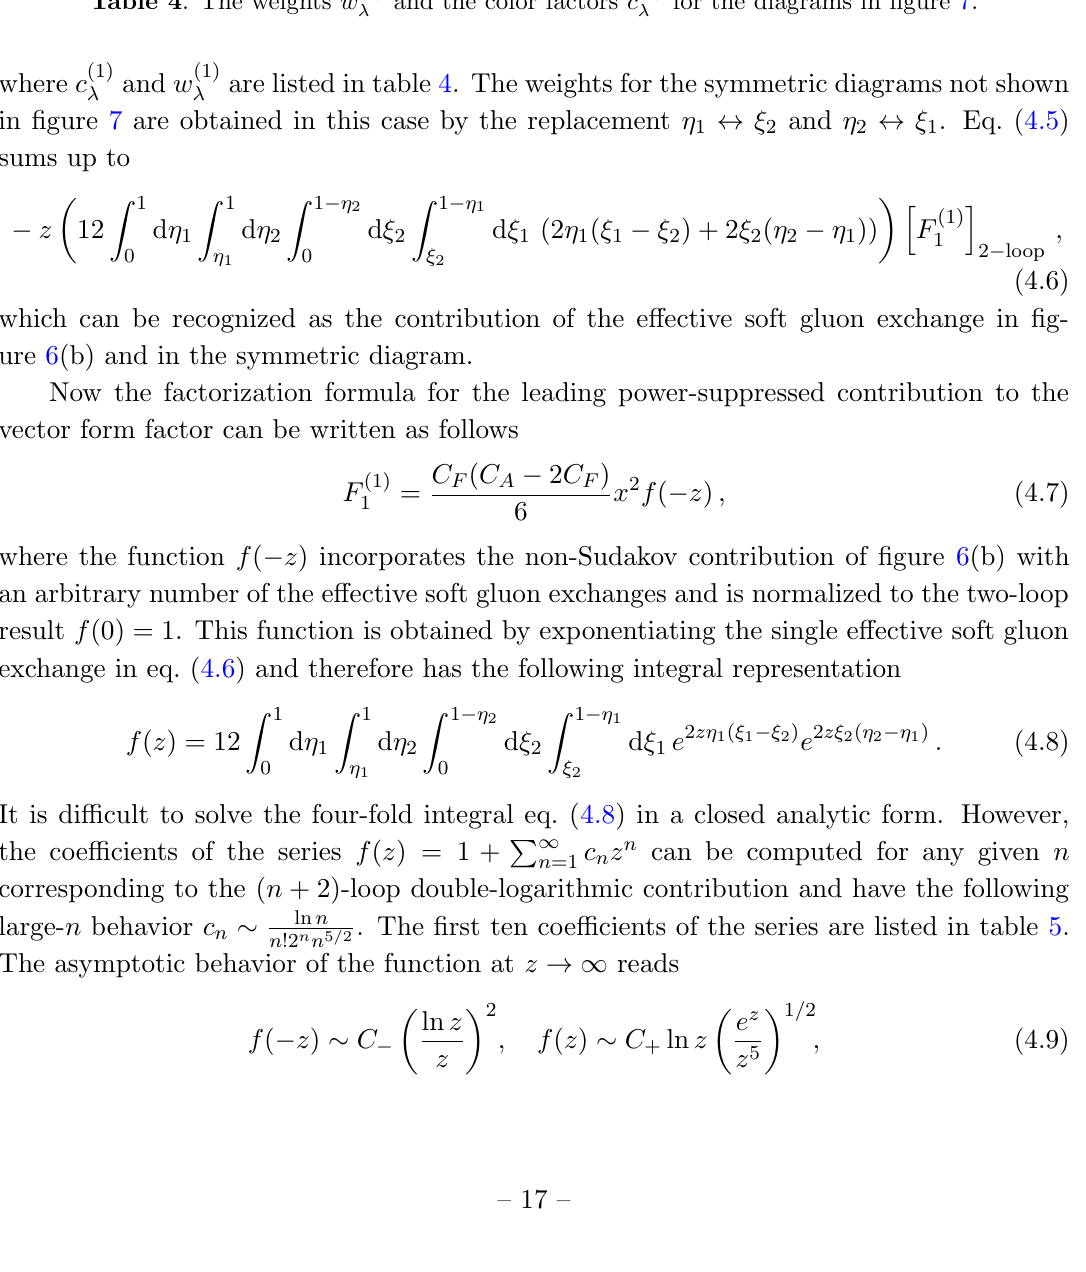
Table 4 . The weights w (1)